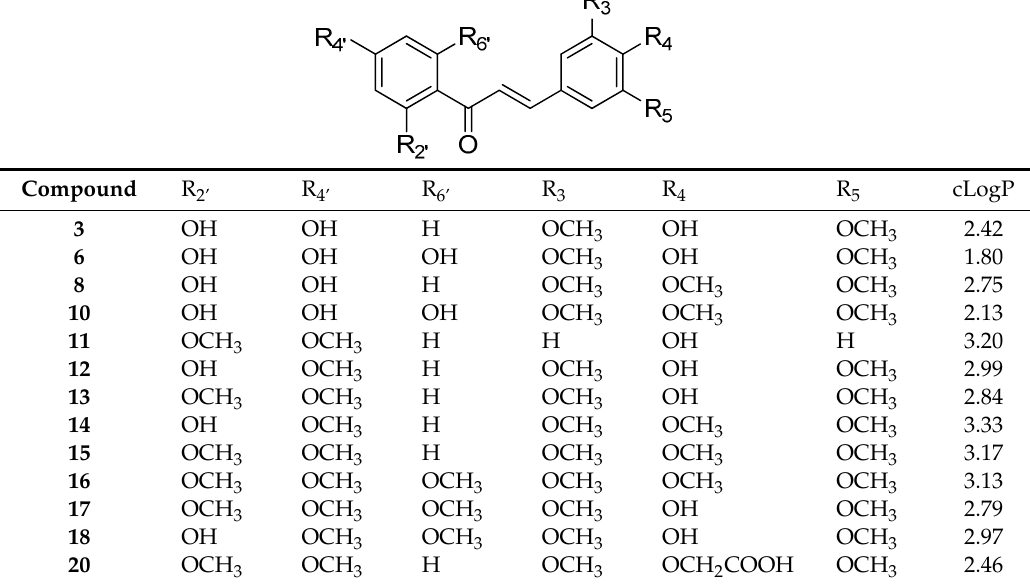
Table 1. Synthesized chalcones and their related cLogP.